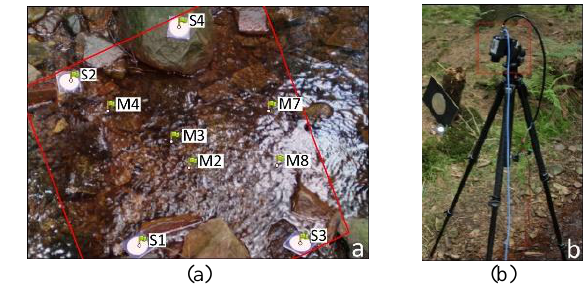
Figure 1. Data acquisition setup: (a) area of interest: GCPs are numbered as S and positions of propeller gauge measurements are marked as M. (b) Thermal camera on tripod above the small river.